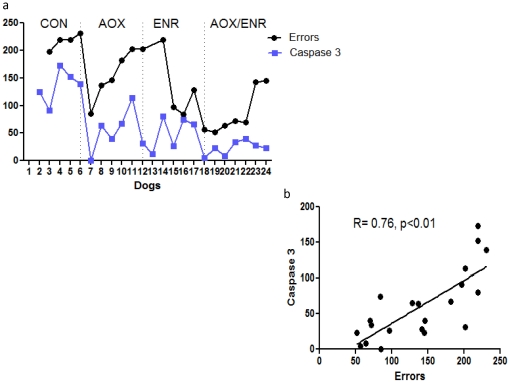
Lower levels of activated caspase 3 activity correlate with better discrimination learning.
a) Parallel relationship between cognitive scores (errors in reversal learning) and abundance of cells expressing activated caspase 3 in each animal b) Caspase 3 expression is directly correlated with errors in reversal learning. Pearson analysis r = 0.76, p<0.01.